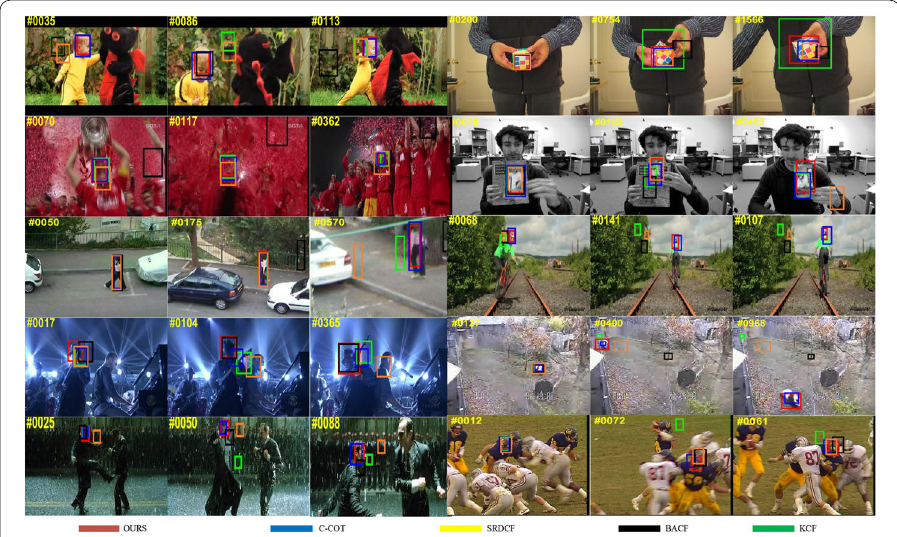
Fig. 13 Qualitative evaluation of the proposed algorithm, C‑COT [9], SRDCF [14], BACF [12], KCF [8] methods on ten challenging video